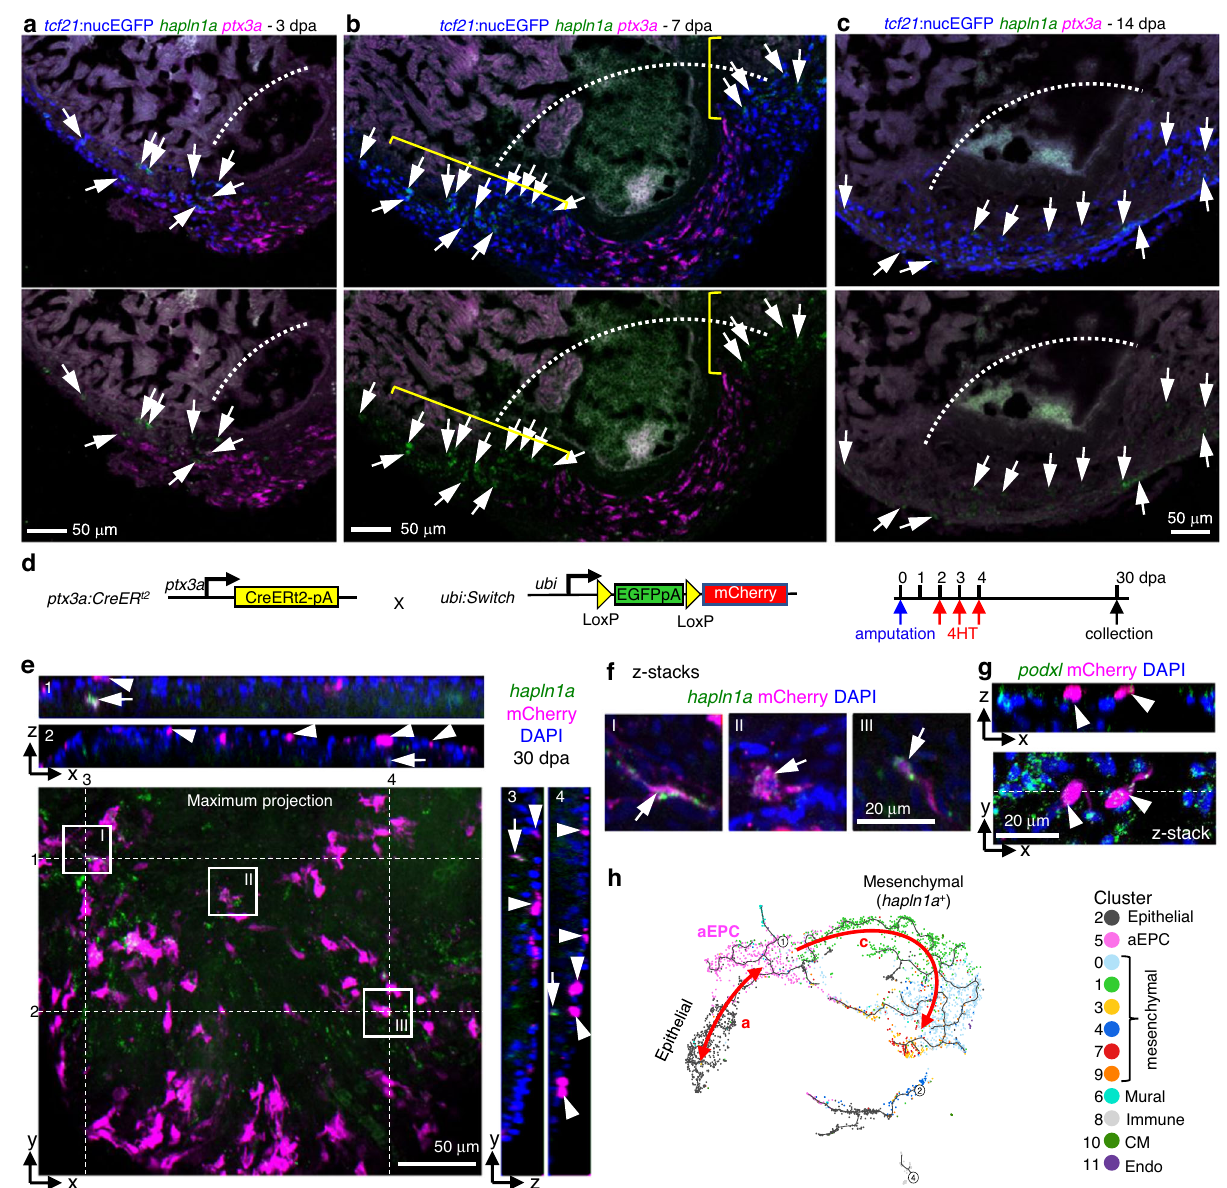
Fig. 6 | aEPCs give rise to the epithelial and mesenchymal epicardial cells. Section images showing HCR staining results of hapln1a (green) and ptx3a (magenta) at 3 ( a ), 7 ( b ), and 14dpa ( c ). Epicardial cells are labeled with tcf21 :nu- cEGFP (blue). Arrows in a – c indicate representative hapln1a + cells. The brackets in b outlinetheregeneratedregionsthatexpress hapln1a .Whitedashedlinesindicate theinjurysites.Scalebars,50 μ m. d Schematicoftransgeniclinesandexperimental design to de fi ne the fate of aEPCs. 4HT was used at 5 μ M. e Orthogonal view of a z-stack image showing the ventricular surface layers from hearts carrying the ubi:Switch;ptx3a:CreER t2 reporters.Amaximumprojectionimageof thex-yplaneis shown with hapln1a expression (HCR staining) in green and mCherry in magenta. White dashed lines and numbers indicate positions for views of the y-z planes (right) and the x-z planes (top), respectively. Nuclei were stained with DAPI (blue)